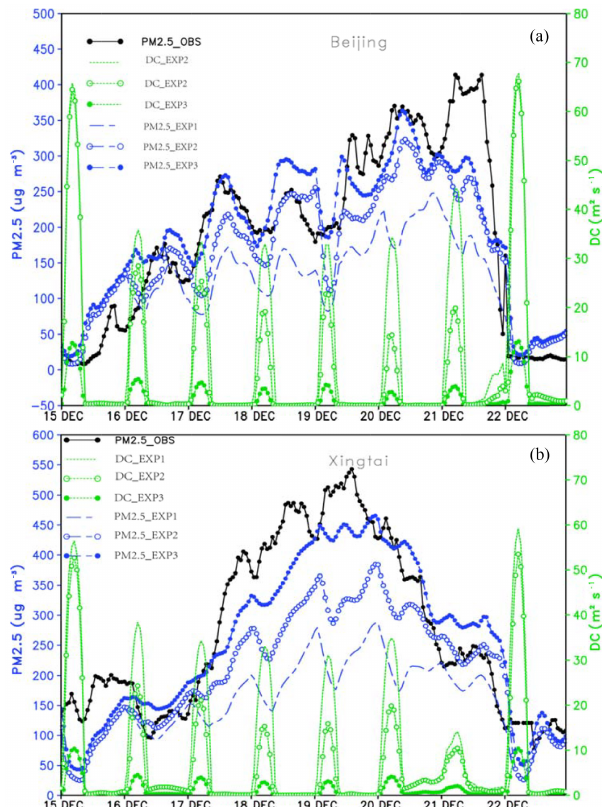
Figure 8. Hourly change of PM 2 . 5 _OBS, PM 2 . 5 _EXP1, PM 2 . 5 _EXP2, and PM 2 . 5 _EXP3 (µgm − 3 ), in addition to the diffusion coefficient (DC) at 950hPa of the three experiments (DC_EXP1, DC_EXP2, and DC_EXP3) during the 15–22 Decem- ber 2016 period in (a) Beijing and (b)